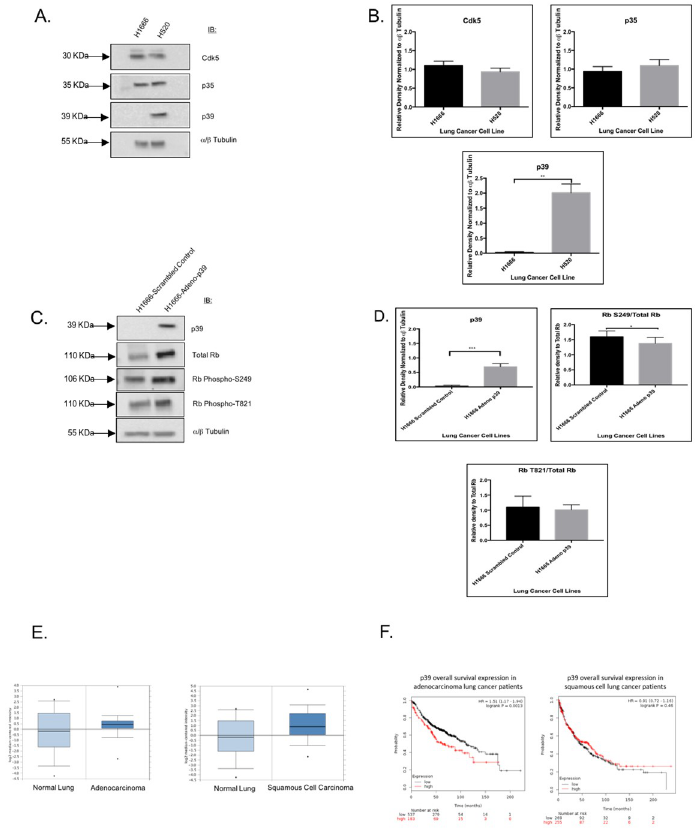
Fig 4. H520 cells have increased levels of the Cdk5 activator p39. (A) Immunoblots showing comparable levels of Cdk5 and p35 in H1666 and H520 cells. However, H520 cells have increased expression of the second major Cdk5 activator p39, relative to H1666 cells. Alpha-beta tubulin was blotted as a loading control. (B) After quantification of band intensity in triplicate immunoblots only p39 expression resulted to be increased in a statistically significant manner in H520 cells relative to H1666 cells (p-value of 0.007) based on an unpaired t-test statistical analysis. (C) Immunoblots showing that phosphorylation levels of Rb S249 and T821 were not significantly affected upon reintroduction of p39 into H1666 cells, in spite of a robust p39 expression in H1666 cells 24 hours after adeno-p39 infection relative to cells transfected with an adenovirus bearing a scrambled p39 sequence. (D) Band intensities in the triplicate immunoblots shown in C . were quantified using the ImageJ Plug-in and phosphorylation in Rb S249 and T821 was graphed after normalization against total Rb. No significant effect on Rb phosphorylation on S249 or T821 upon p39 forced expression in H1666 cells can be detected, with p-values shown at the top of each graph. (E) NSCLC microarray expression data from the Oncomine database (http://www.oncomine.org, Compendia Bioscience, Ann Arbor, MI, USA), specifically from the study conducted by Bhatacharjee et al. This study contained 139 lung adenocarcinomas, 21 squamous cell carcinomas, 6 small cell lung carcinomas, and 17 normal lung tissues. Datasets were ordered by overexpression of CDK5R2 (p39), which was analyzed by Affymetrix U95A microarrays (Affymetrix ID 36361_at). Box plots show that p39 is over-expressed 1.76-fold in AC relative to normal lung (p-value of 0.060) and that the p39 overexpression is more pronounced in SCC by 2.71-fold relative to normal lung (p-value of 0.012). (F) Kaplan Meier plots showing reduced overall survival of AC patients with higher expression of p39 (p-value of 0.0013), the effect being less pronounced and non-statistically significant in SCC patients. The plots were generated using the KM Plotter Online Tool (http://www.kmplot.com), which relates microarray expression data (Affymetrix ID: 20582_at, in this case for p39 expression) with clinical outcomes. Statistical tests were assessed by Mann-Whitney tests when comparing two groups and Kruskal Wallis when comparing three groups or more. Statistical significance was set as: � p-value < 0.05, �� p-value < 0.01, and ��� p-value <